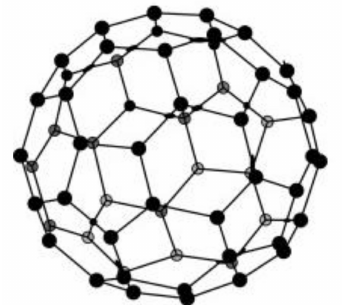
Figure 5. Spherical structure of fullerene. Reprinted from [140] with permission of